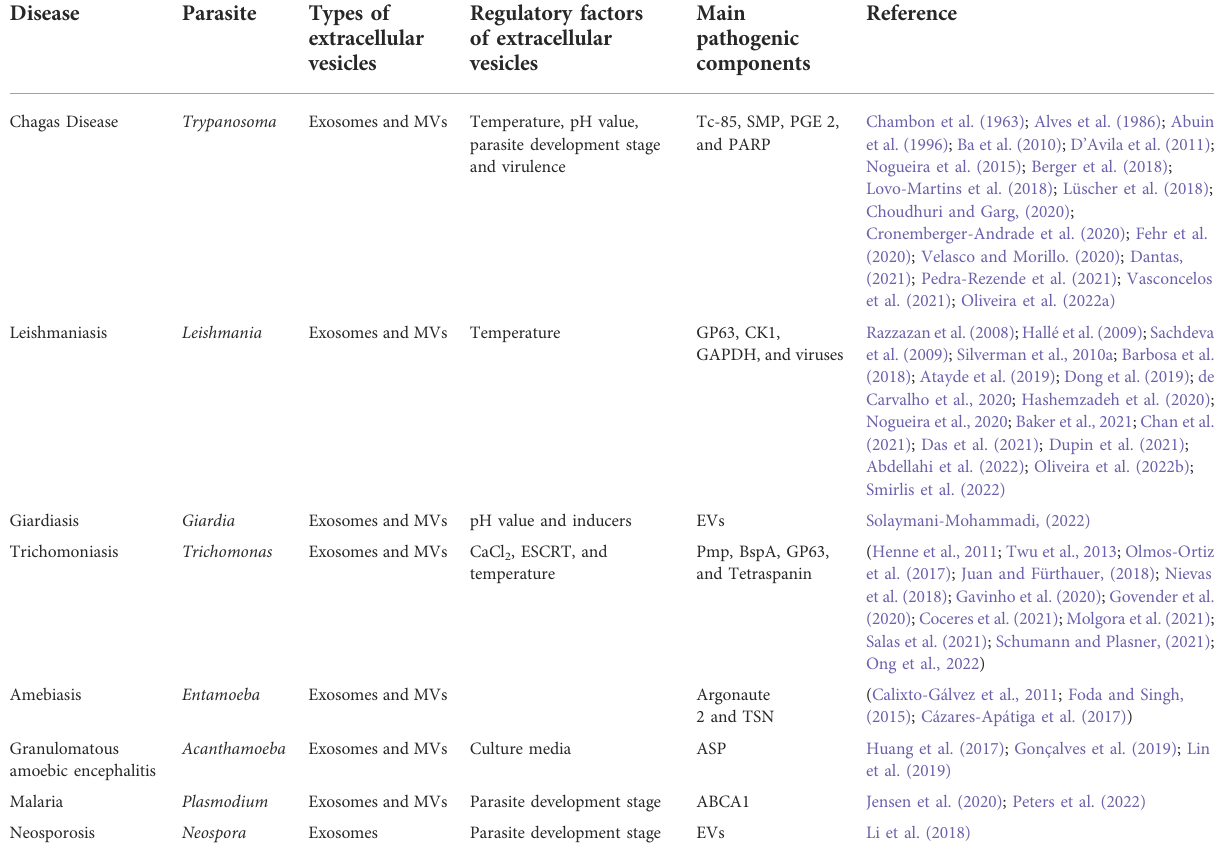
TABLE 1 Extracellular vesicles shed by different parasites and the associated signaling